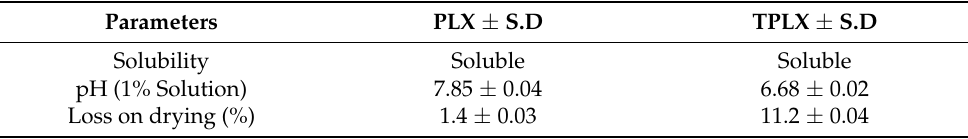
Table 2. Physicochemical properties of PLX and thiolated PLX.